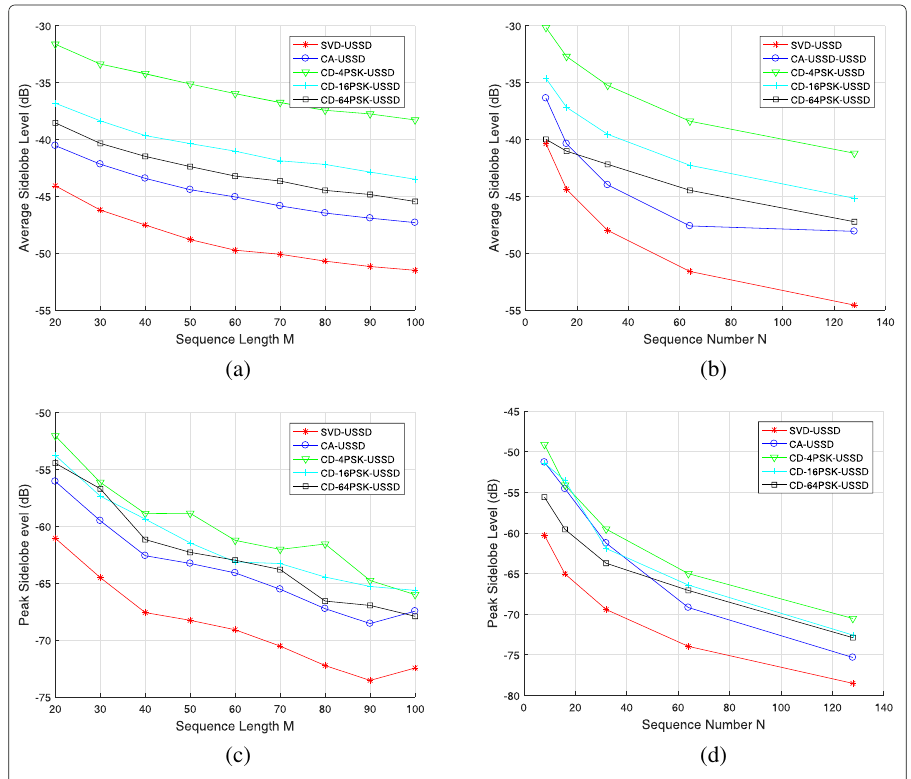
Fig. 2 Curve of average sidelobe level vs. sequence length and sequence number of the sequence set optimized by SVD-USSD, CA-USSD, and CD algorithms, a ASL vs. M , b ASL vs. N , c PSL vs. M , and d PSL vs. N